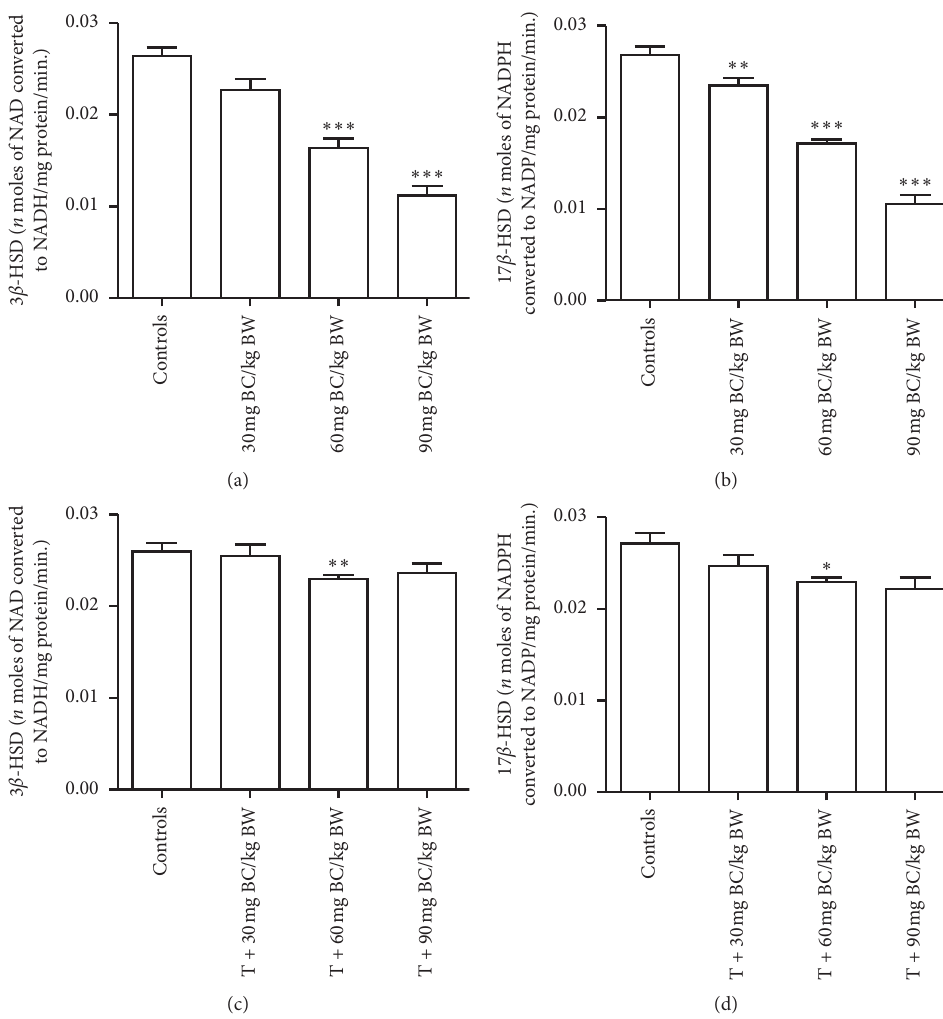
Figure 5: Testicular steroidogenic marker enzymes 3 β -((a) and (c)) and 17 β -((b) and (d)) hydroxy steroid dehydrogenase (3 β -and 17 β - HSD) titers in F1 adult mice exposed to baicalein (BC) without ( n � 6) or with ( n � 4) testosterone (T) injection. ∗ , ∗∗ , and ∗∗∗ represent significantly difference from controls at P < 0 . 05, < 0.01, and < 0.001,